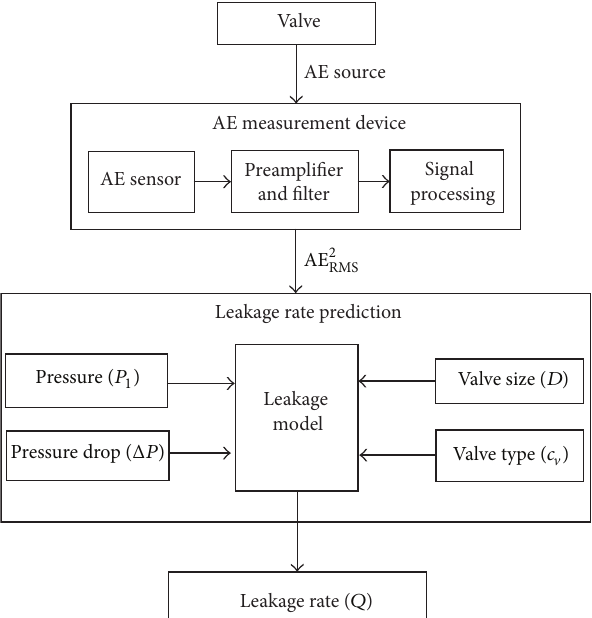
Figure1:Processestopredictvalveleakageratebyacousticemission [27].